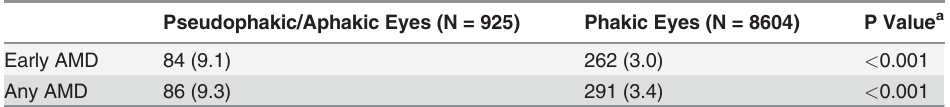
Table 3. Distribution of AMD by presence or absence of previous cataract surgery.